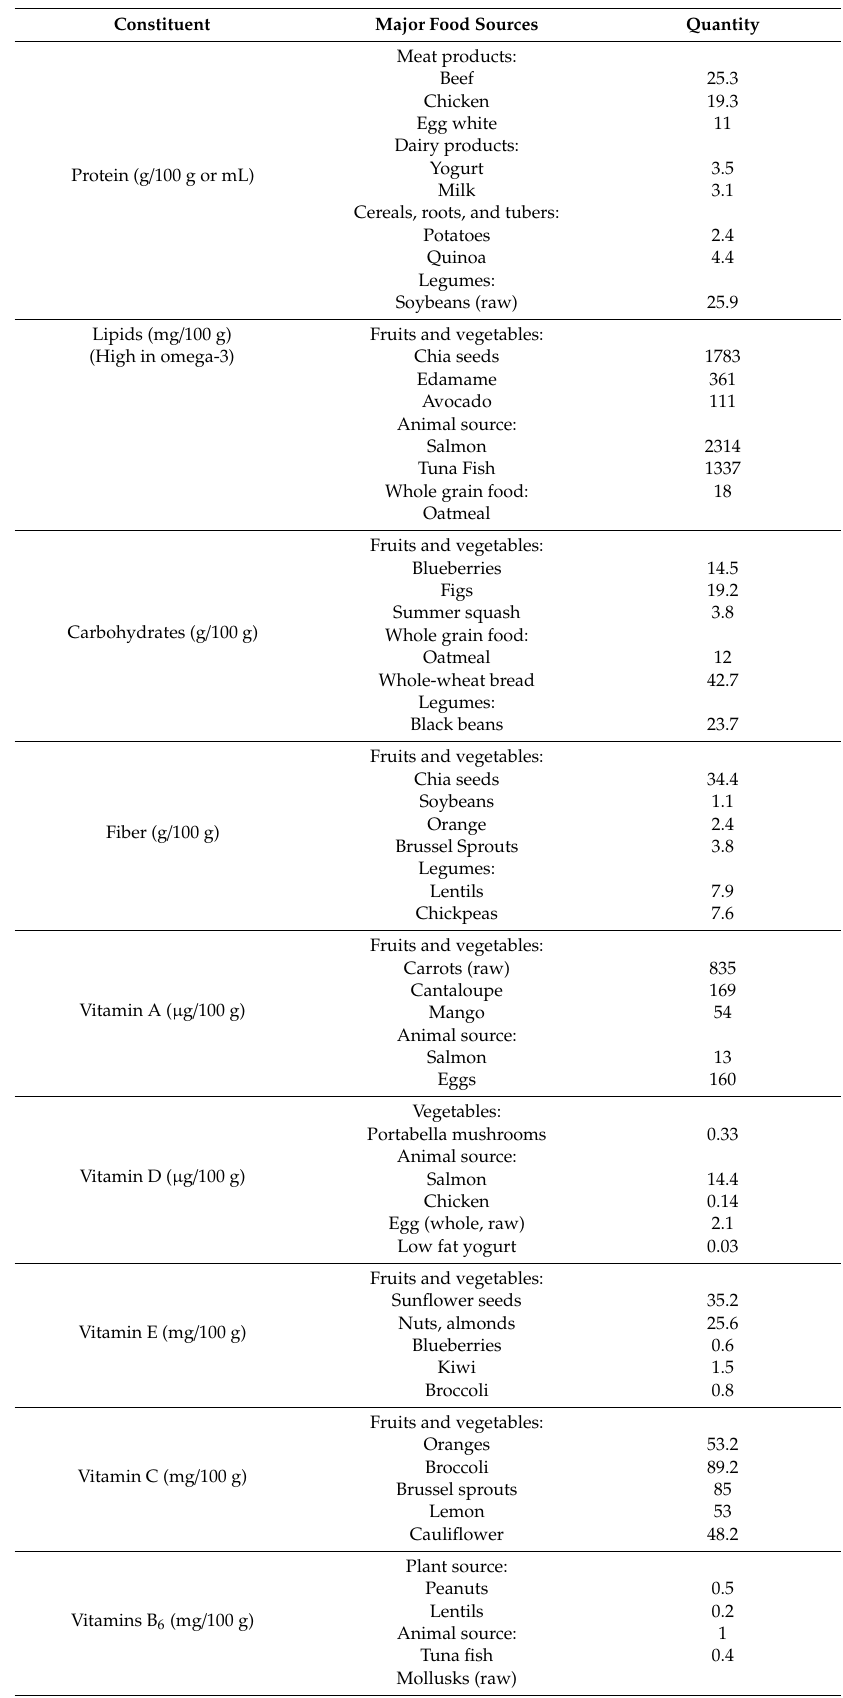
Table 2. Examples of dietary